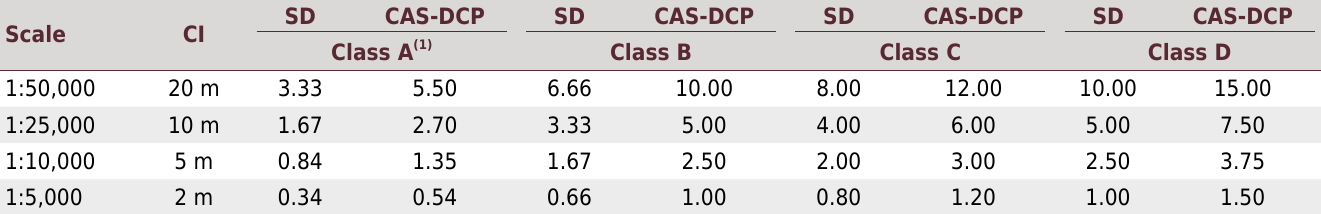
Table 1. Scales tested in this study, their respective contour intervals (CI), standard deviation (SD) and Cartographic Accuracy Standard – Digital Cartographic Products (CAS-DCP), according to the Brazilian Cartographic Accuracy Standards Law (BCASL)